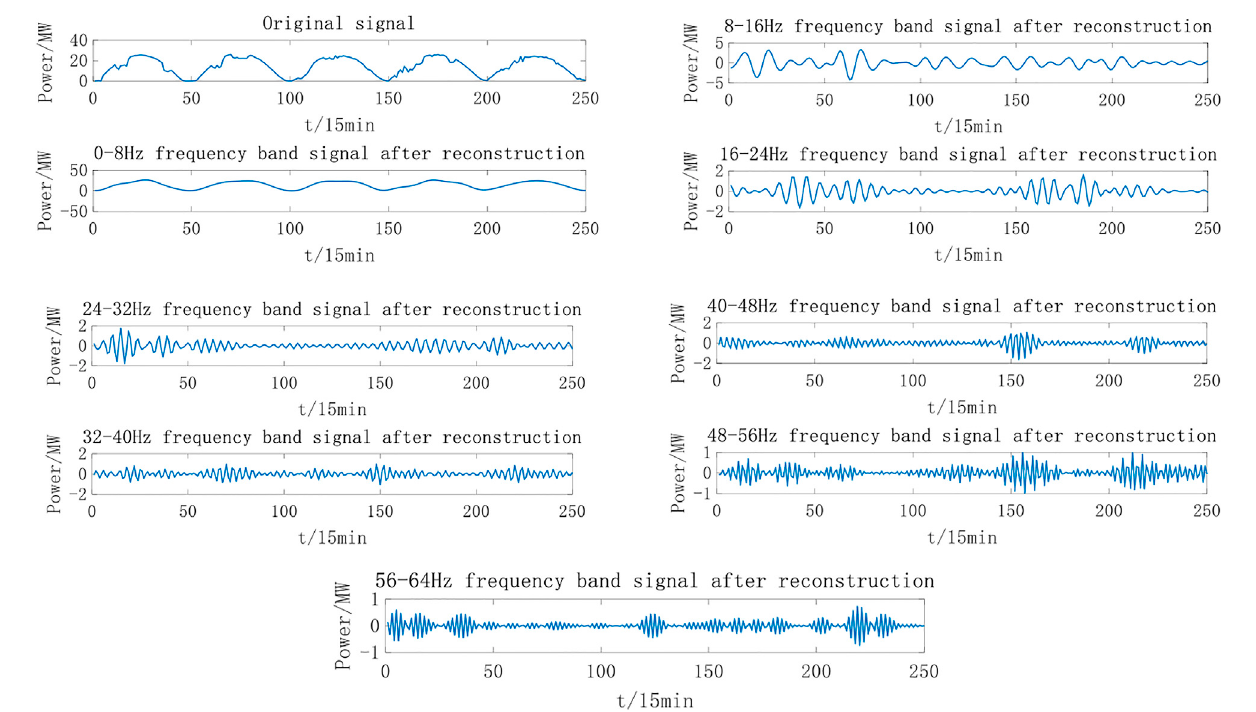
FIGURE 5 | Frequency components of PV power plant output power processed by